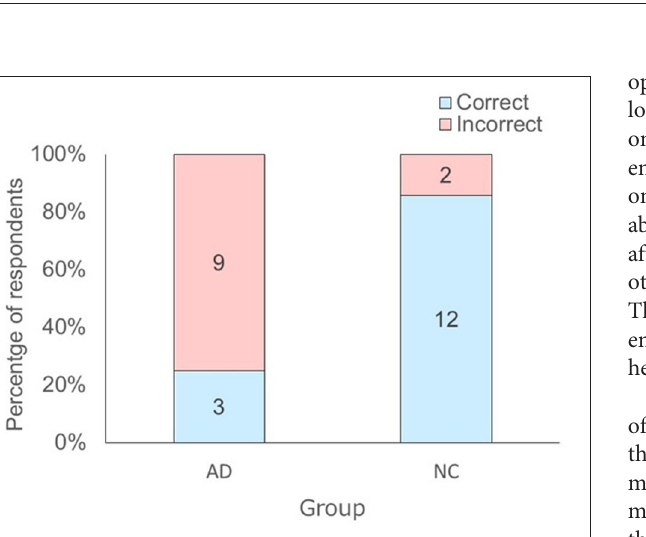
FIGURE 4 | Distribution of the answers of the respondents to the question “Which actor drew a winning ticket?” depending on respondent group. The number in each bar represents the answers of the respondents to the question. AD, Alzheimer’s Disease; NC, Normal